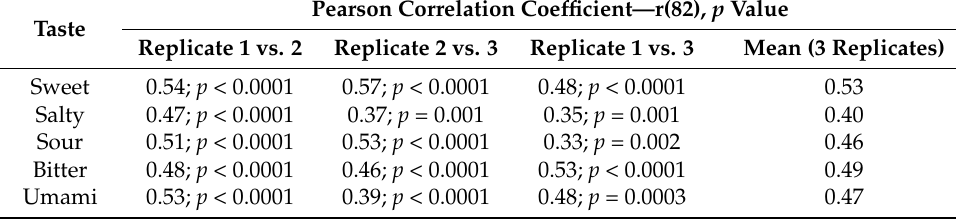
Table 1. Repeatability of the taste sensitivity test. Pearson correlation coefficients calculated between the scores obtained during the three repetitions. Pearson Correlation Coefficient—r(82), p Value